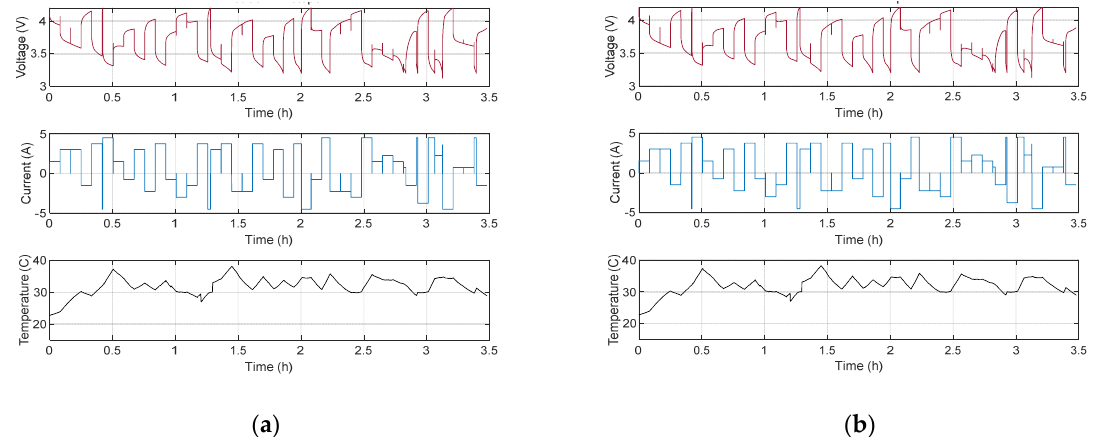
Figure 2. The RW steps measured for battery RW9: ( a ) first 50 RW steps; ( b ) last 50 RW steps.